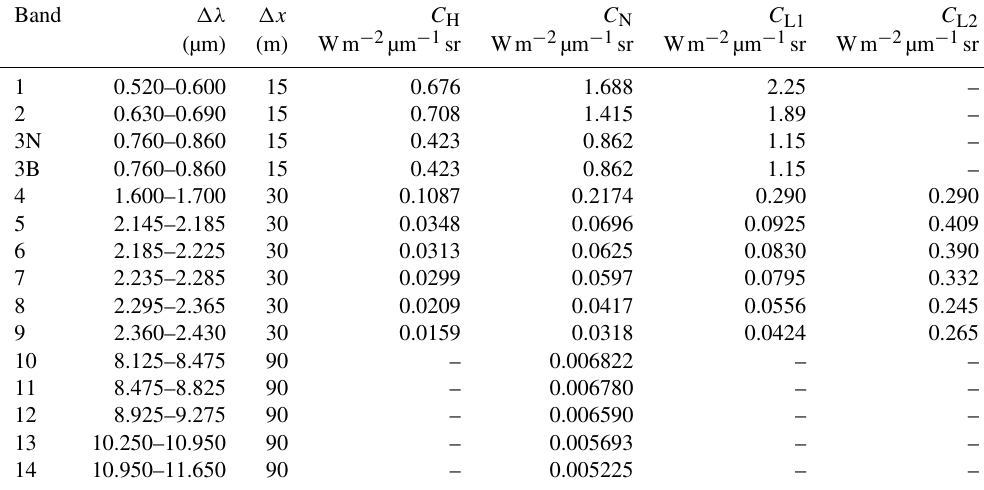
Table 1. Overview of ASTER band numbers, wavelength range ( (cid:49)λ ) covered by each band, spatial resolution ( (cid:49)x ), as well as unit conversion coefficients ( C H , C N , C L1 , C L2 ) for high, normal, low-1 and low-2 gains,